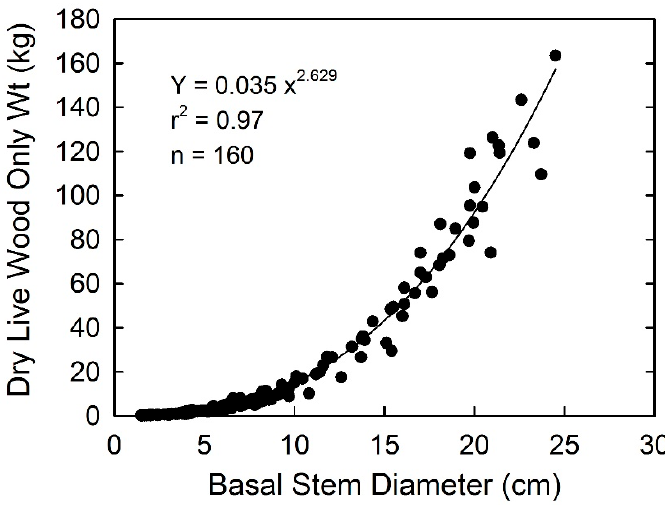
Figure 1. Relationship between mesquite basal stem diameter and oven dry live wood weight supported by that stem.